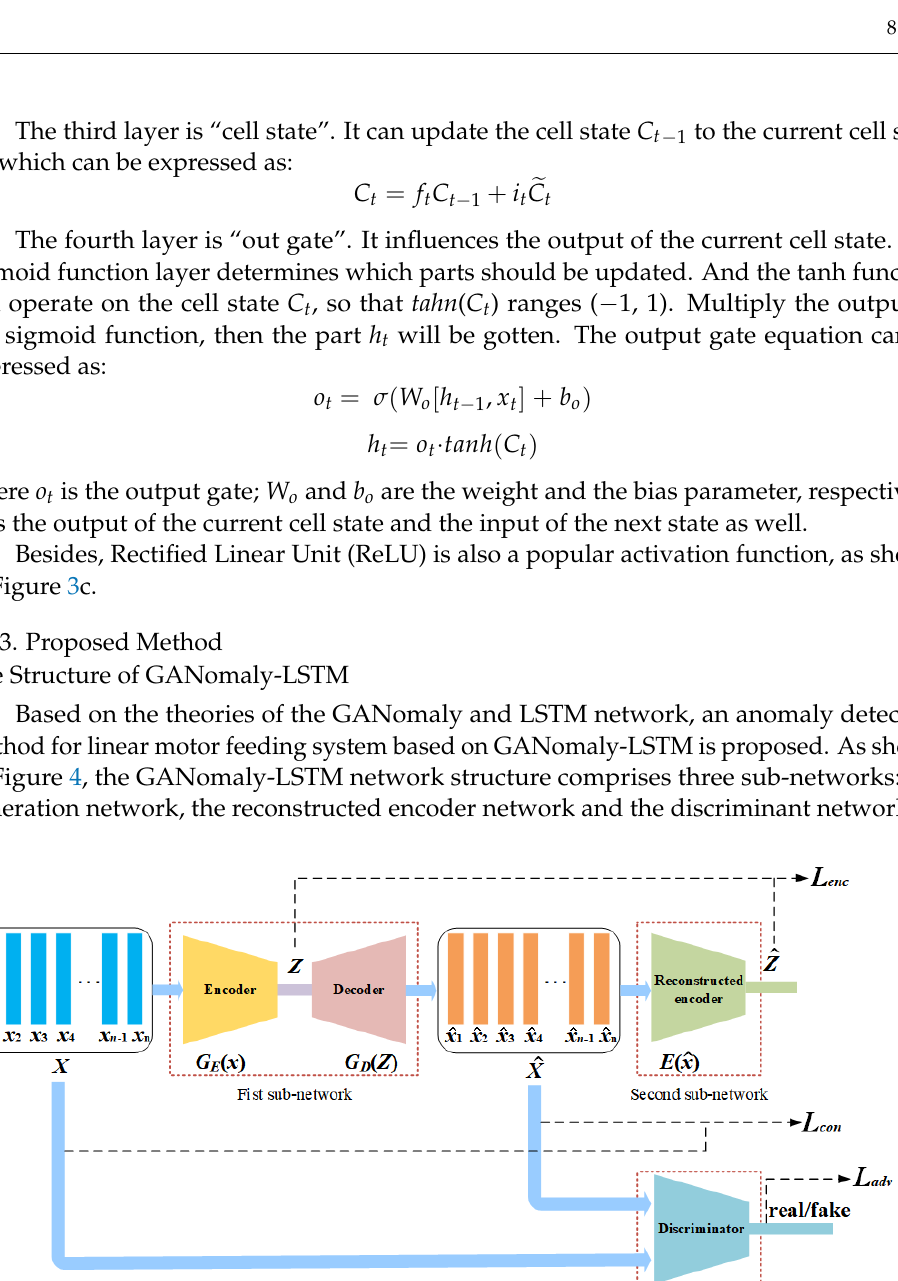
Figure 5. Network structure of encoder.